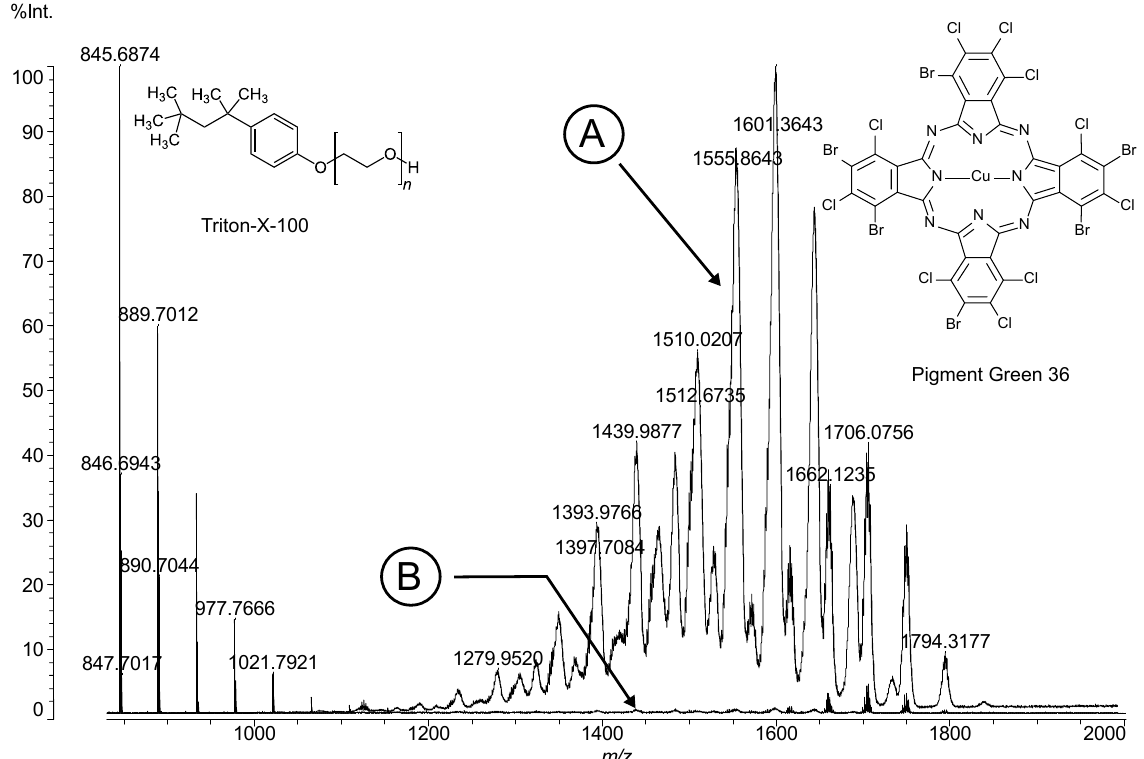
Figure 1. High resolution mass spectra of Pigment Green 36 (C.I. 74265) without any discrimination effect ( A ) and affected by the surfactant Triton X-100 ( B ).